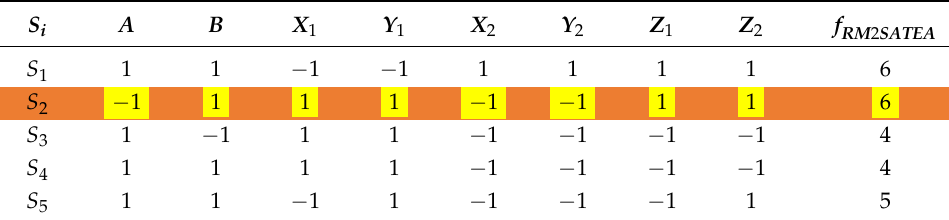
Table A1. S 2 selected as candidate in Party 1.